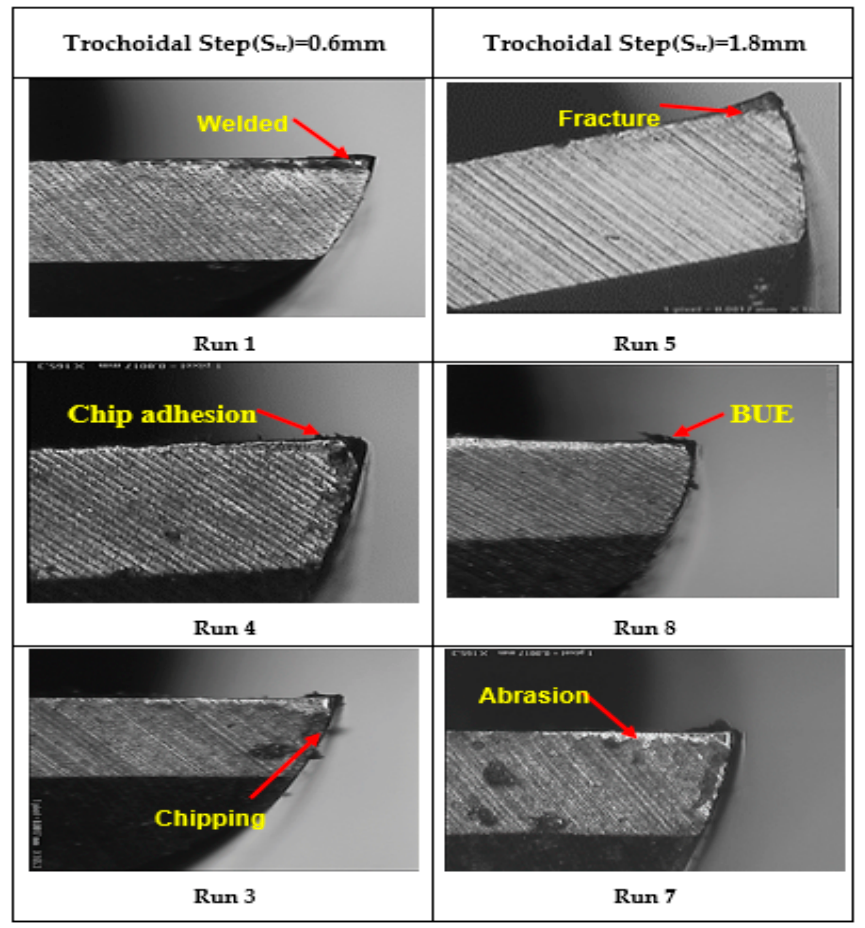
Figure 11. E ff ect of trochoidal step on dish angle (Tool wear) using Vision measuring system Figure 11. Effect of trochoidal step on dish angle (Tool wear) using Vision measuring system (corresponding to run numbers in Table (corresponding to run numbers in Table 4).